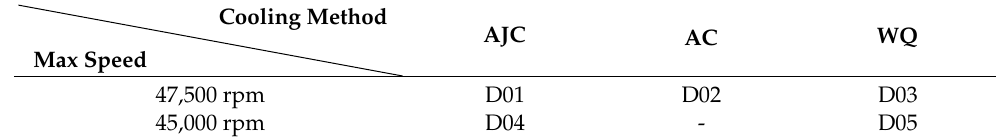
Figure 11. Schematic of the test device.